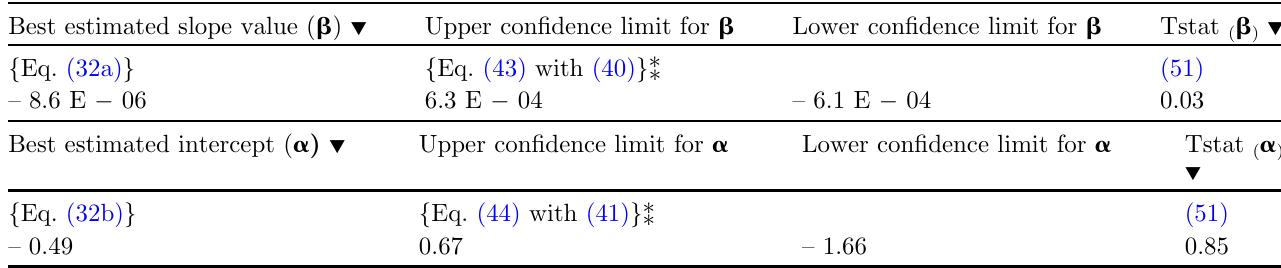
Table 6. Example 4. FAC-1; system A; linear regression analysis results; slope & intercept. Best estimated slope value ( b ) ▾